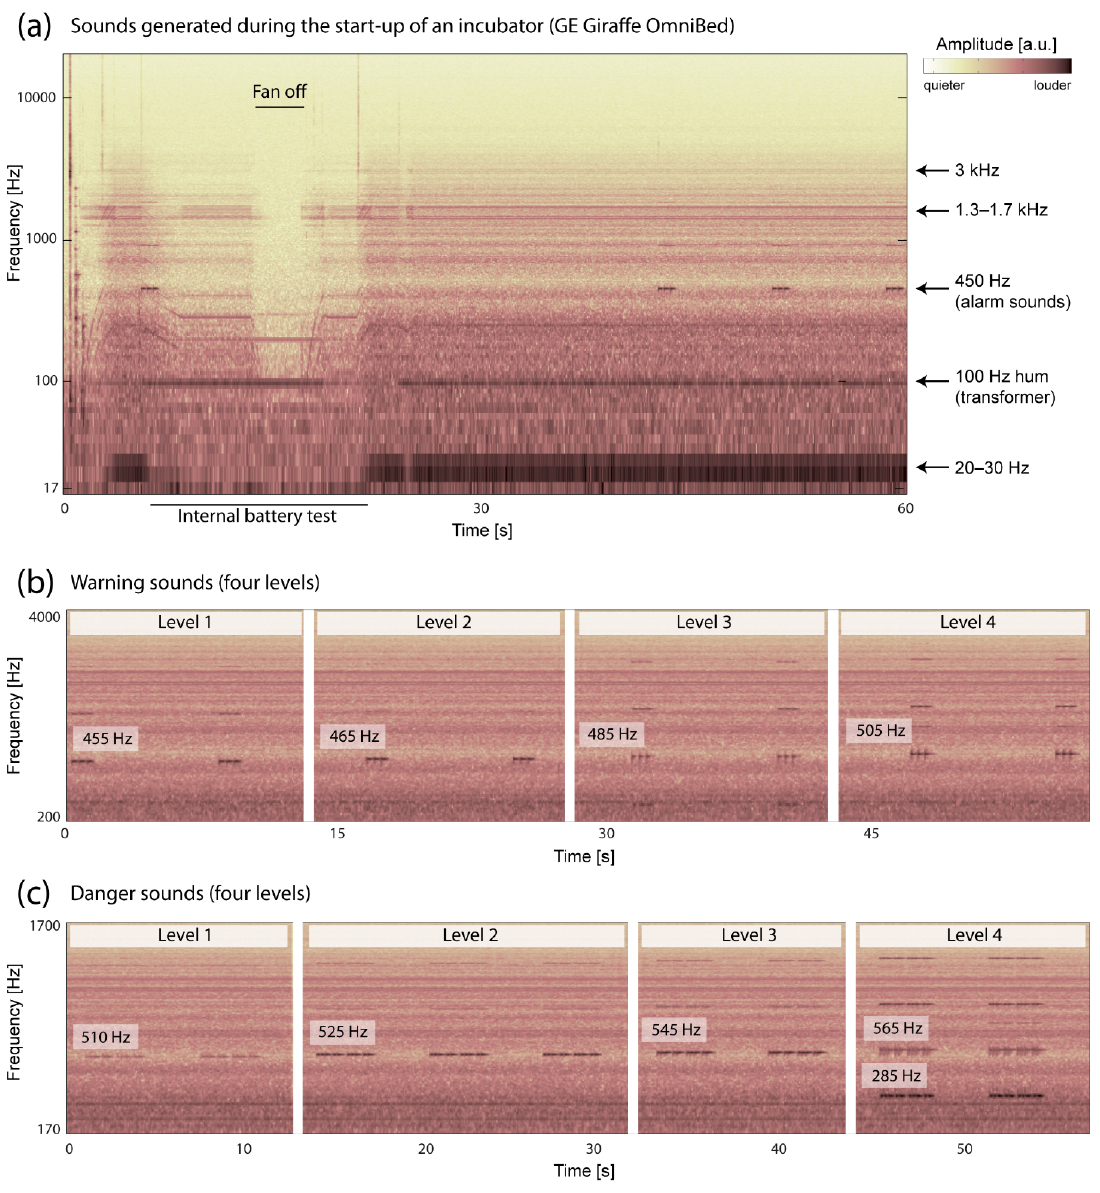
Figure 2. ( a ) Spectrogram of the noise produced by the incubator during the start-up phase. ( b , c ) Spectrograms of the warning and danger sounds produced by the IntelliVue MX550, Philips monitor next to the incubator.